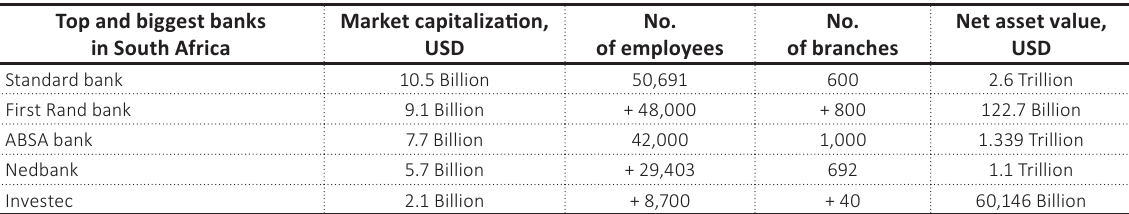
Table 1. Overview of the top 5 South African commercial